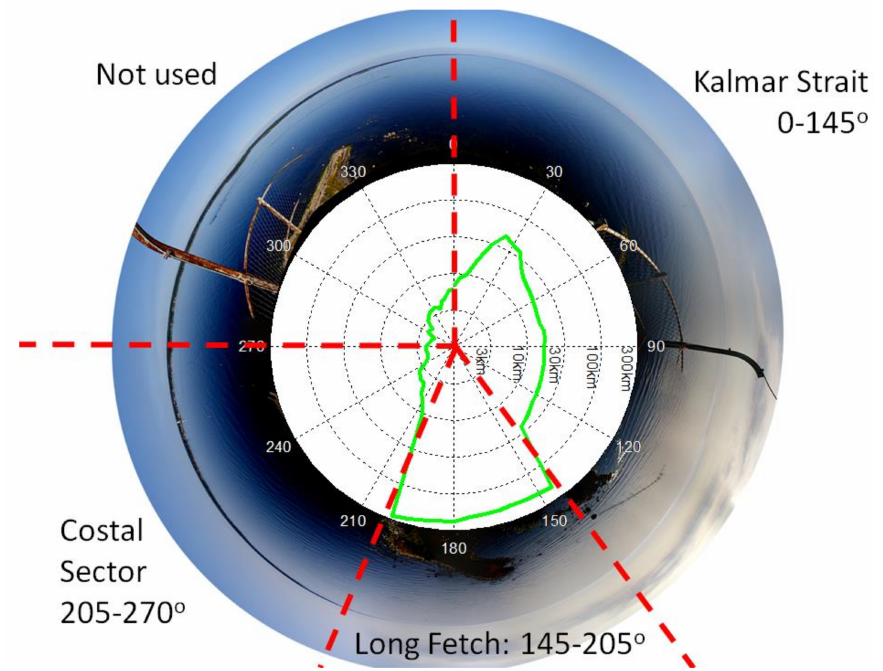
Figure 2. The central figure shows the fetch on a logarithmic scale in each wind direction. A 360 ◦ spherical panorama was made using the PTGui software to stitch together 10 original images that were taken with a Pentax K20D at 18 mm focal length from the top platform of the Garpen lighthouse, before the eddy covariance (EC) flux system was installed. The projection was not surface proportional, but objects were projected at roughly the size they are seen by an observer at the center point. The panorama was orientated so that up was north and down was south. To the left (west), one can see the Swedish east coast, but to the right (east), the coast of the island of Öland is out of sight. In the south and southeast, the open Baltic Sea opens up. The island of Garpen can be seen around the central figure, together with some distorted details of the lighthouse’s top platform railing, and at about 285 ◦ , the light house lightning